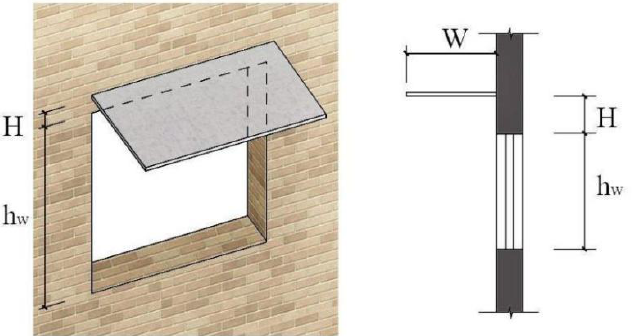
Figure 7. Details of the shading devices; drawn by the authors.